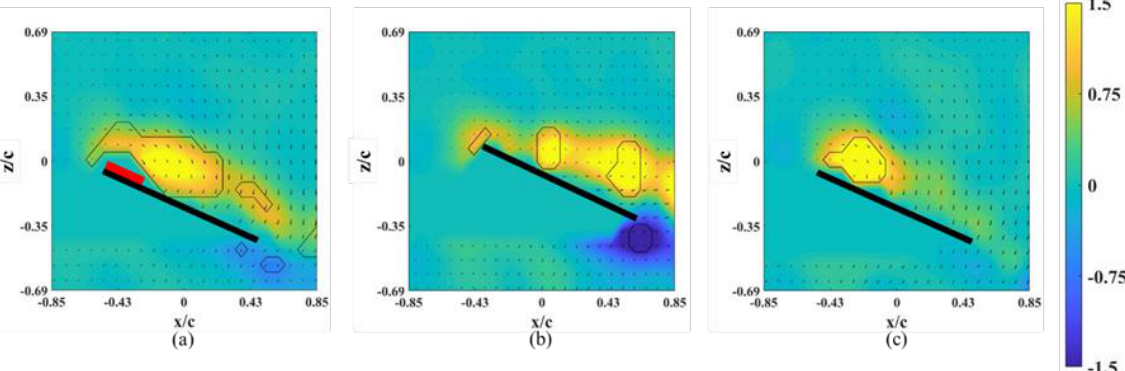
Figure 9. Vorticity contours around the wing model with an alula-VG placed at L w * = 0.50 ( r* = 0.62) and α = 25 ◦ . ( a ) r* = 0.61, ( b ) r* = 0.71, and ( c ) r* = 0.81.